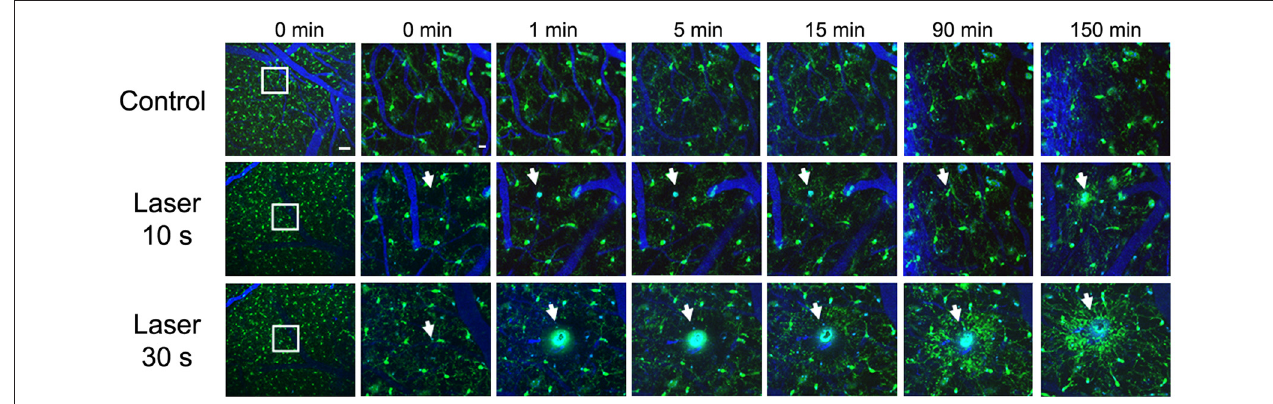
FIGURE 2 | Real time in vivo multiphoton imaging of microglia in the cerebral cortex from CX3CR1-GFP mice. Representative images of sequential follow up of a control mouse and two mice after parenchyma laser ablation for 10 and 30 s. Same regions are imaged before the lesion, immediately after, 1, 5, 15, 90 and 150 min afterwards. Microglia processes start going towards the lesion site as soon as 1 min after laser ablation and the processes continue extending towards the lesion 150 min later. Vessels (blue) are filled with Texas Red dextran 70 KD, microglia (GFP, green) and white arrows point to laser ablation sites. Scale bar 50 µ m and insets 12 µ